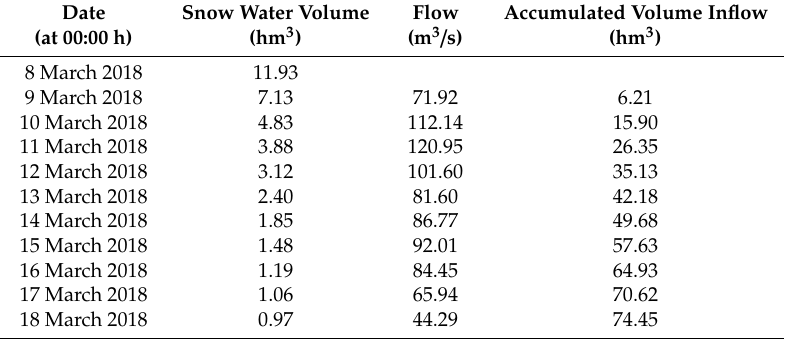
Table 2. Expected values of average daily flows entering the Rosarito reservoir from AEMET (most unfavourable) temperature and rainfall predictions. Between 8 March, 2018 and 18 March, 2018, near 11 m 3 , are coming from snowmelt.